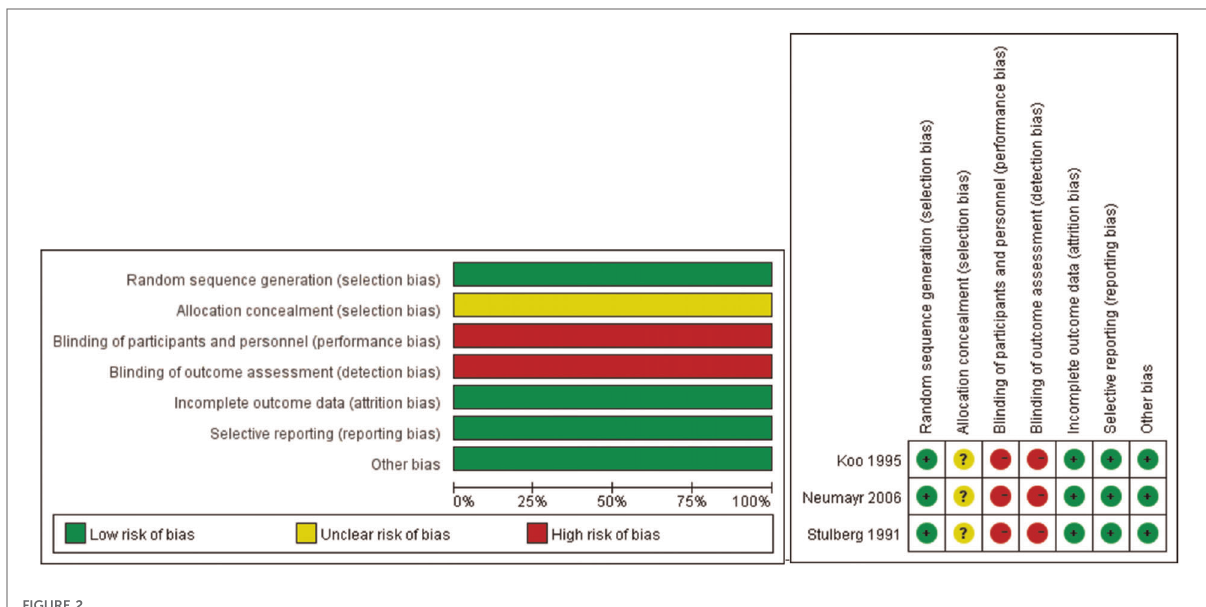
FIGURE 2 Methodological quality of the RCTs.